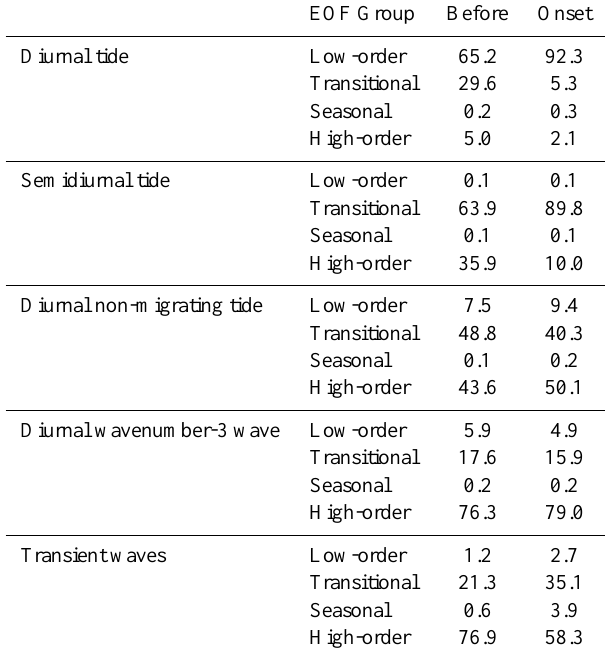
Table 4. Energy percentage per EOF group before and at the onset of the 2001 dust storm in the various atmospheric motions under analysis.